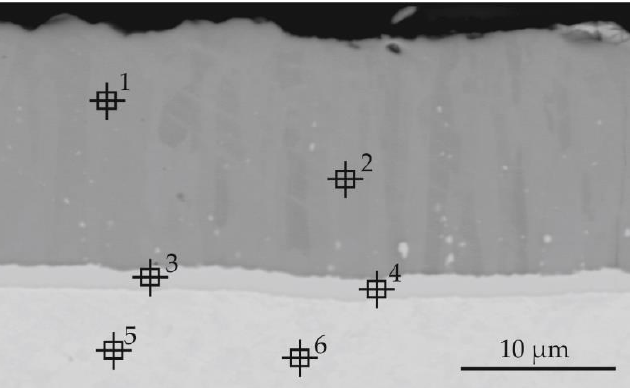
Figure 5. The microstructure (BEI) of Si coatings obtained at 1000 °C for 4 h with the slurry volume of ( a ) 0.15; ( b ) 0.3; and ( c ) 0.6 g/cm 2 .